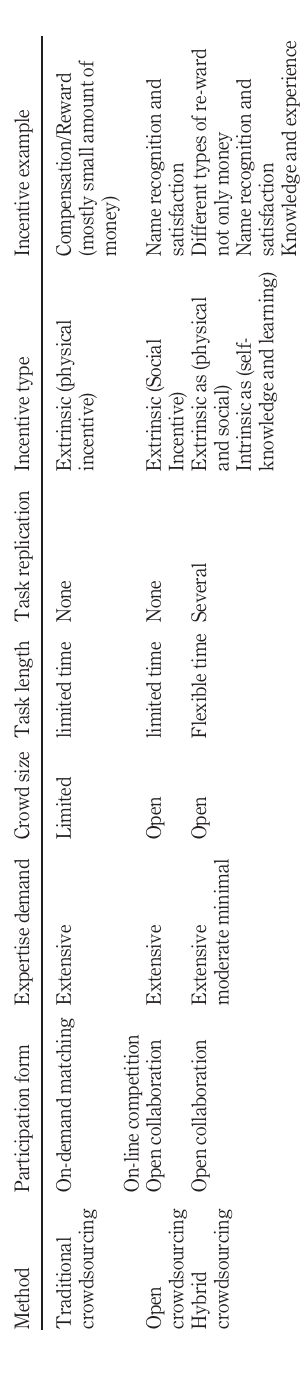
Table I. The comparison of the three crowdsourcing